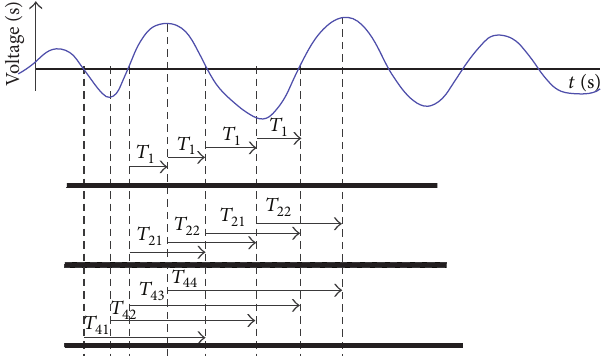
Figure 7: Calculate the instantaneous frequency based on GZC